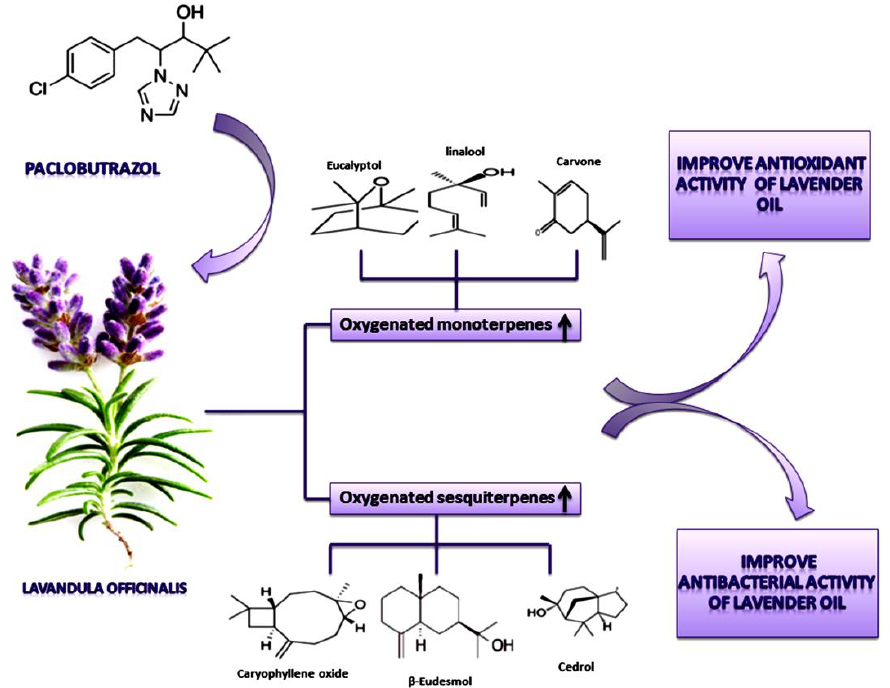
Figure 8. Simplified model for the suggested effect of paclobutrazol (PBZ), as a foliar application, on Lavandula officinalis L., improving the Antioxidant and Antimicrobial Properties of the extracted oil through modification of its composition from the oxygenated terpenes.